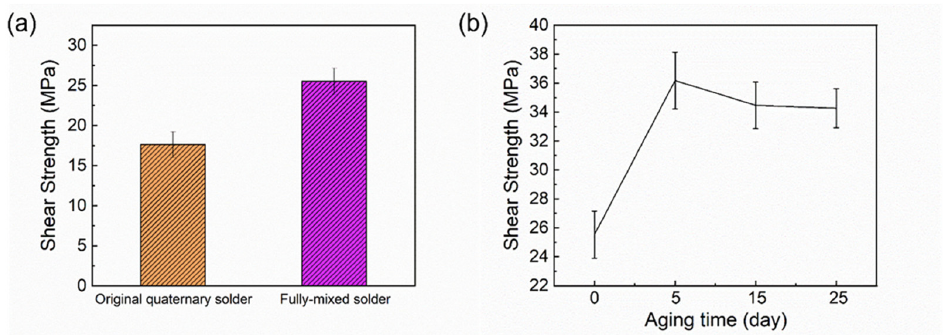
Figure 15. ( a ) Shear strength of the original quaternary solder joint and the fully mixed solder joint; ( b ) Variation of shear strength of fully mixed solder joint with aging time.